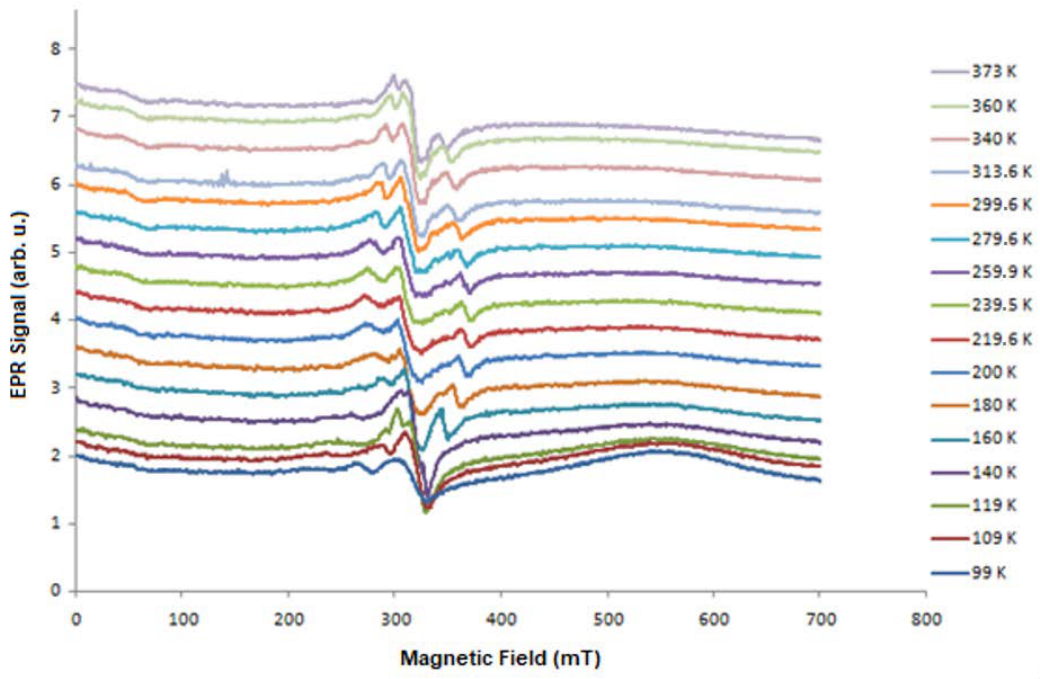
Figure 3. Temperature dependence of the PbSe EPR signal